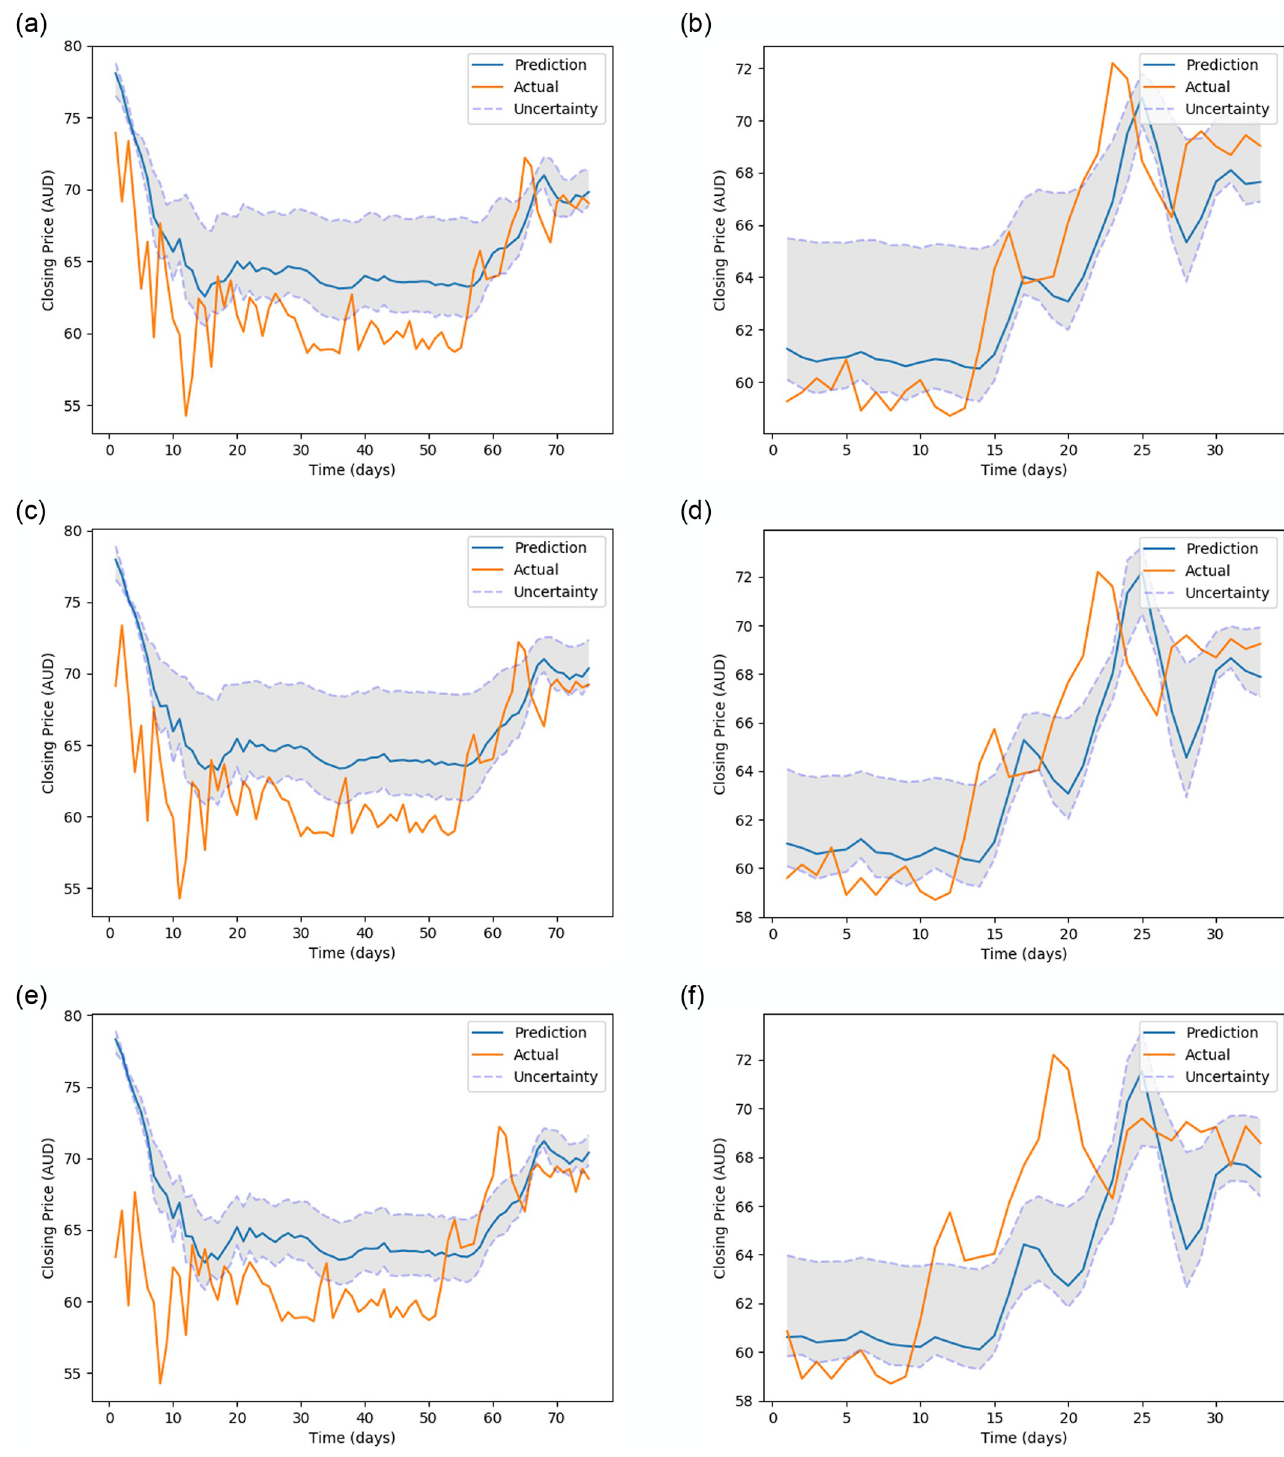
Fig 12. Prediction and uncertainty over test data of CBA.AX (data setup 1 vs data setup 2).